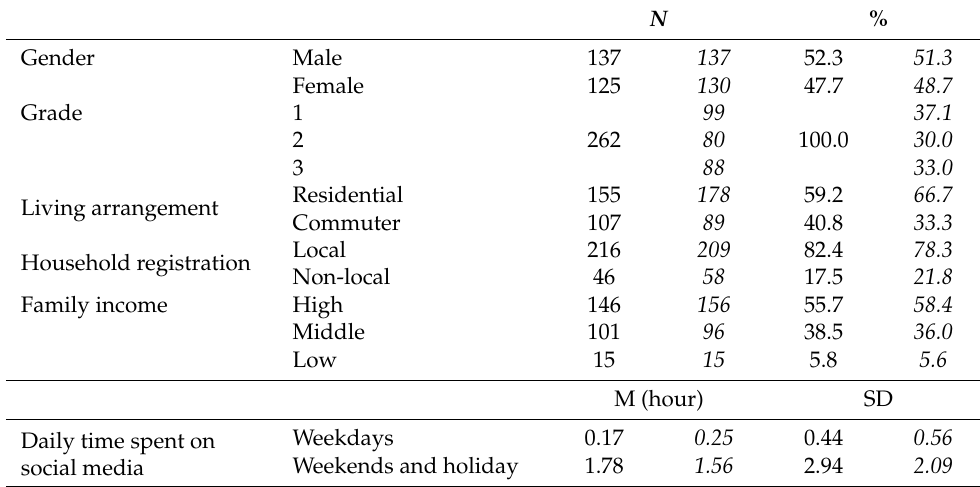
Table 1. General characteristics of participants.